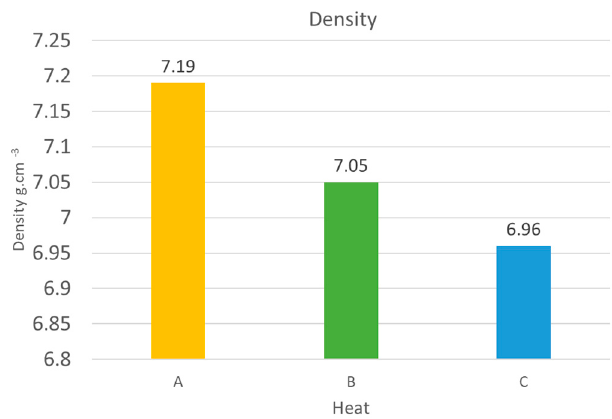
Figure 21. The density of individual heats.